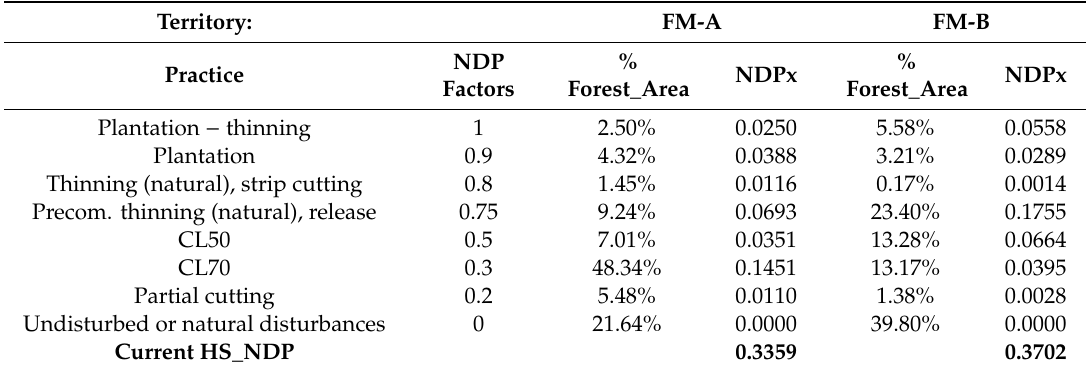
Table A2. Naturalness degradation potential for horizontal structure (HS_NDP) by silvicultural treatment in Montmorency Forest.